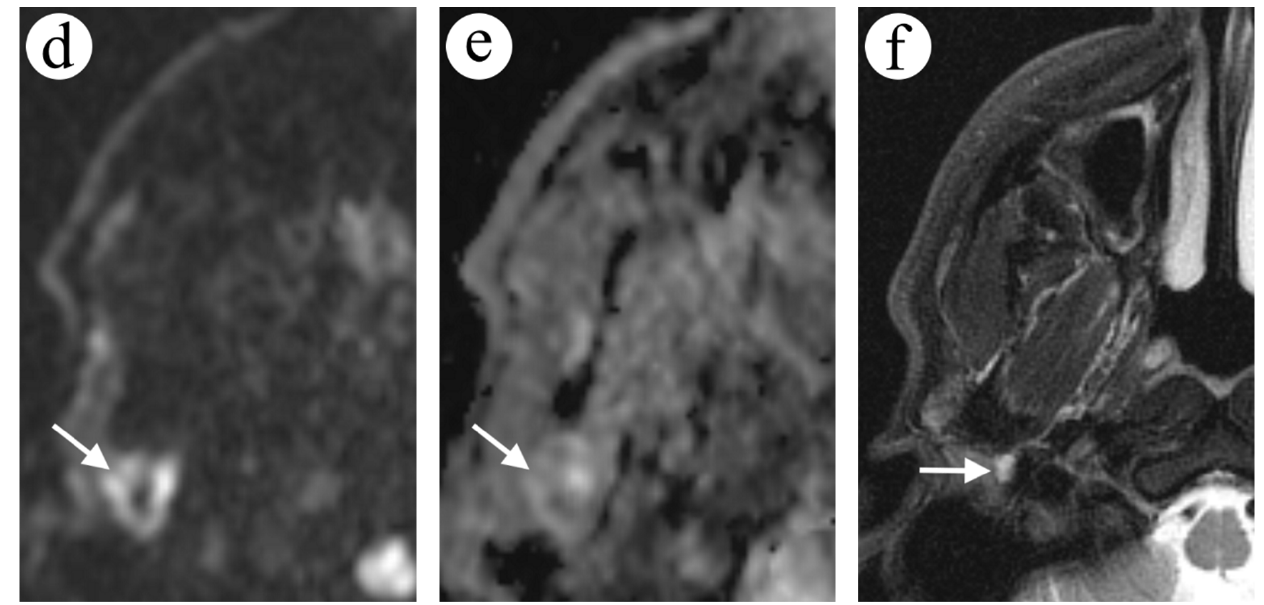
Figure 3. A focal lesion between the right parotid gland’s superficial and deep lobe in US and MRI. In the coronal plane in the US examination, the lesion was heterogenous and hypoechoic ( a ). In the fat-saturated gradient echo sequence (VIBE Dixon) in the axial T1-weighted image ( b ), a lobulated lesion with hyperintense foci in the periphery is visible (arrow). In the fat-saturated turbo spin echo sequence in the axial T2-weighted image, the lesion (arrow) was strongly hyperintense ( c ). The lesion presented diffusion restriction in the rim in readout-segmented DWI ( d ) and ADC maps ( e ). In the fat-saturated turbo spin echo sequence in the axial T2-weighted image in the previous examination ( f ), the lesion (arrow) was much smaller.